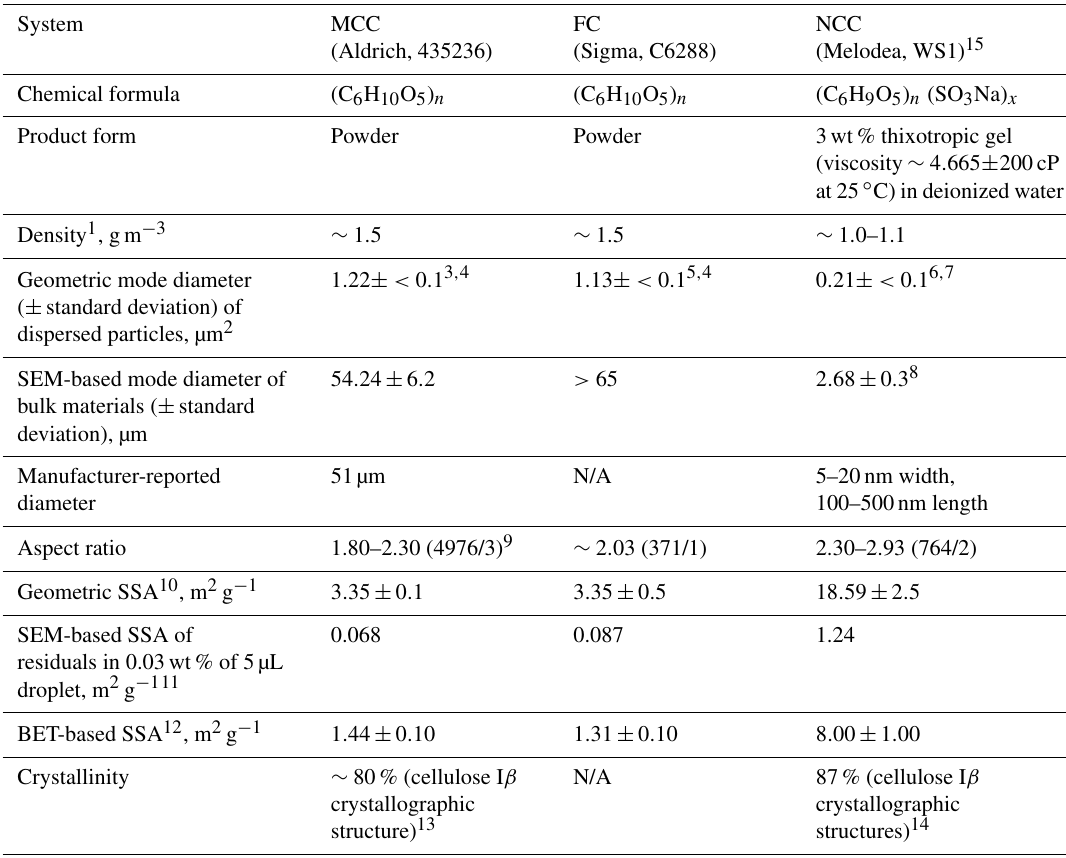
Table 1. Properties of microcrystalline cellulose (MCC), fibrous cellulose (FC) and nanocrystalline cellulose (NCC).